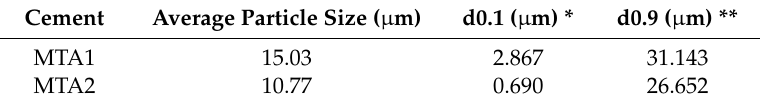
Table 1. Granulometric characteristics of MTA1 and MTA2 cements.